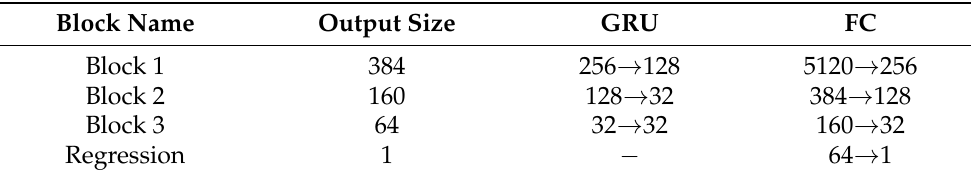
Table 1. TMB architectures considered in our experiments. Each FC layer of the TMB block place the feature into GRU after shrinking. The left and right side of the arrow represent the feature size before and after shrinking, respectively. The output vector of width 64 is finally fed to a FC layer that outputs a quality score in the regression